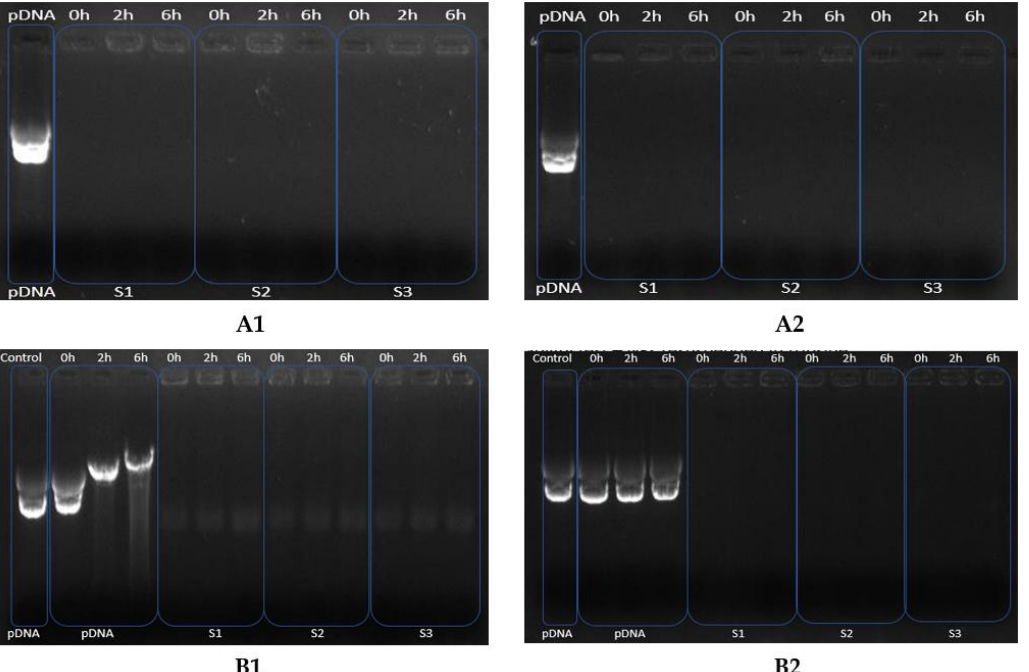
Figure 4. Electrophoretic analysis of NPs supernatants after the formulation step and before the NPs incubation with medium ( A1 ) and trypsin ( A2 ). Lane 1: pDNA control, lane 2–10: non-encapsulated pDNA samples 1, 2 and 3, incubation of 0, 2 and 6 h. Electrophoretic analysis of the system’s protection of pDNA after its incubation with DMEM-F12 medium supplemented with 10 % of serum FBS ( B1 ) and after its incubation with trypsin in ( B2 ). Lane 1: pDNA control; lane 2–4: pDNA with medium, at 0, 2 and 6 h. Lane 5–13: CS-TPP-pDNA sample 1, 2 and 3 with medium at 0, 2 and 6 h; Figure B2: same order, with trypsin.